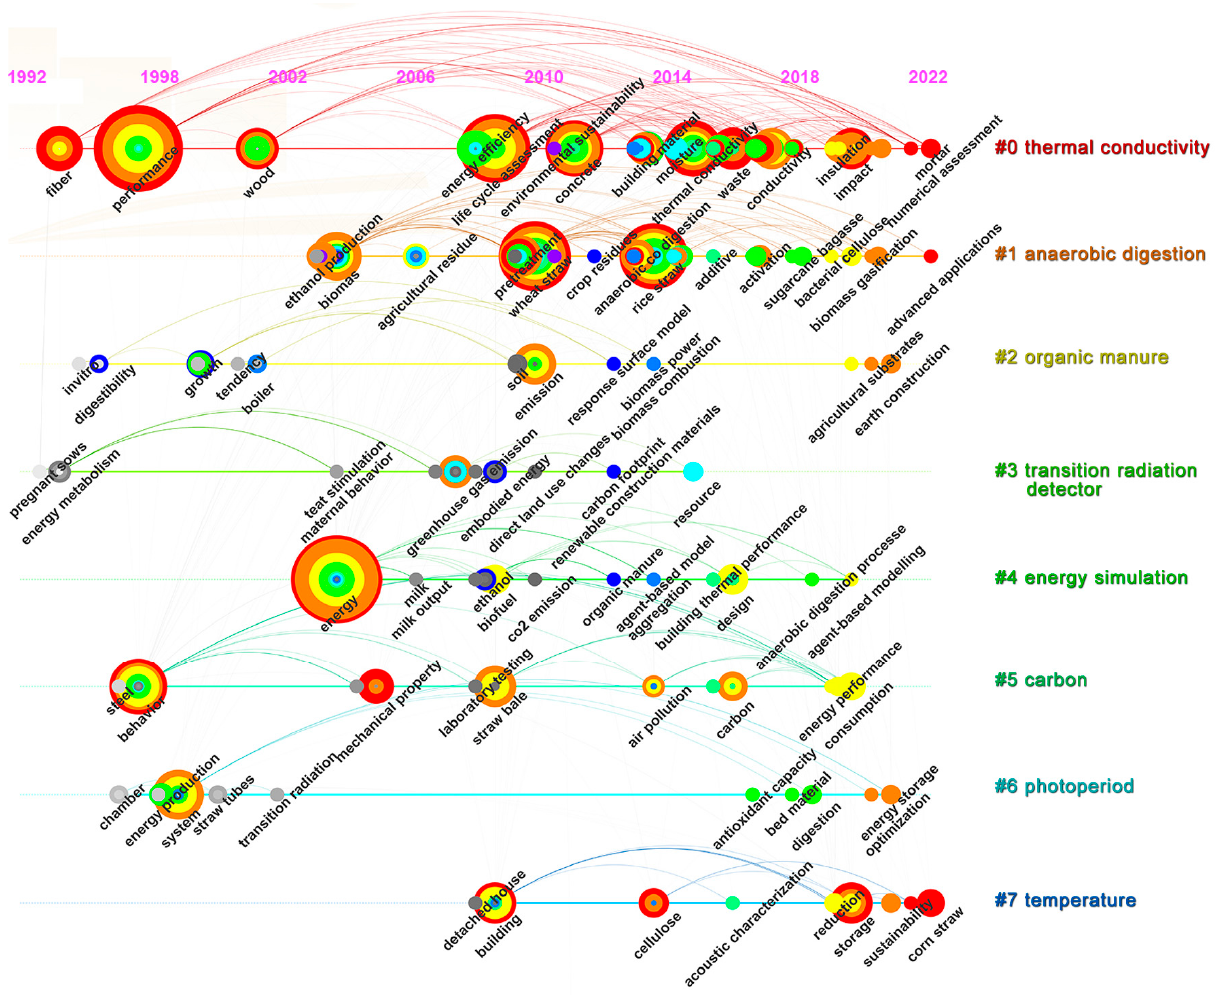
Figure 7. Analysis of hot trends of keyword time mapping research.